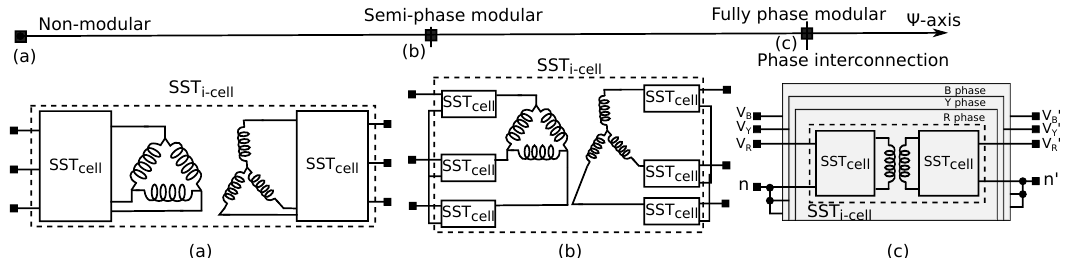
Figure 18. Modularization based on phase interconnection: ( a ) non-modular SSTs, ( b ) semi-phase modular SSTs, and ( c ) fully phase modular SSTs.